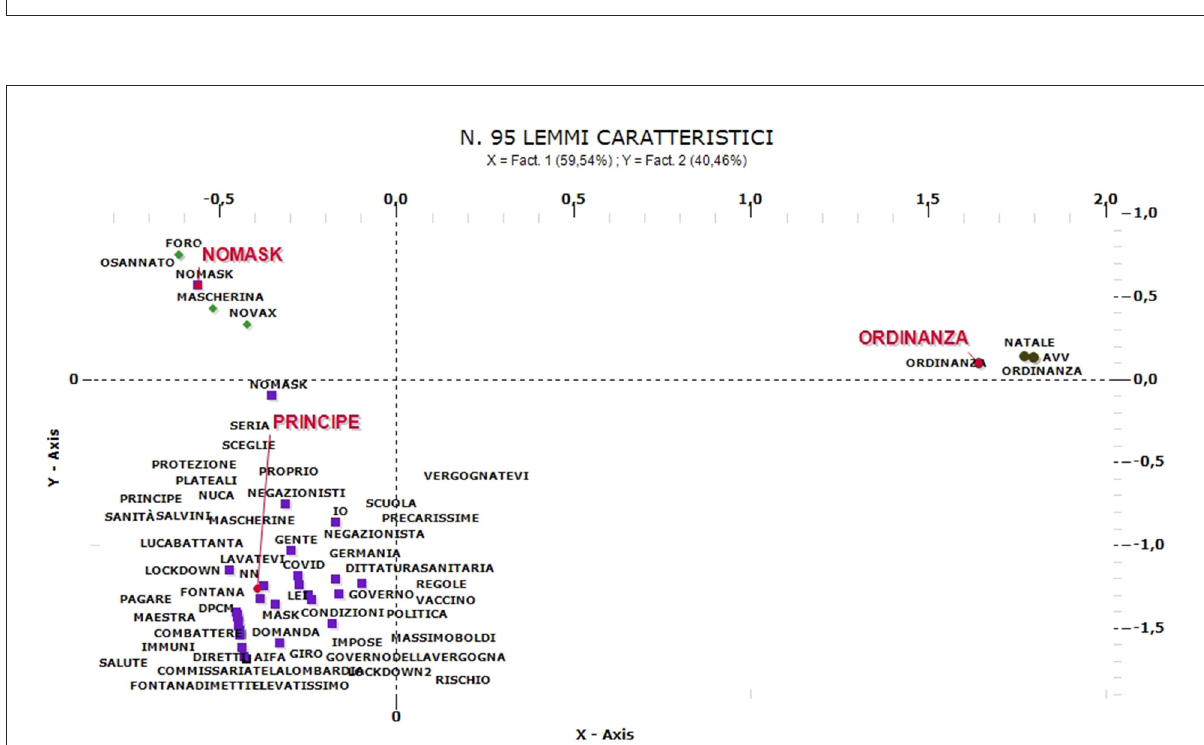
FIGURE9 ACM—“No-mask” comments in Italian (95 characteristic